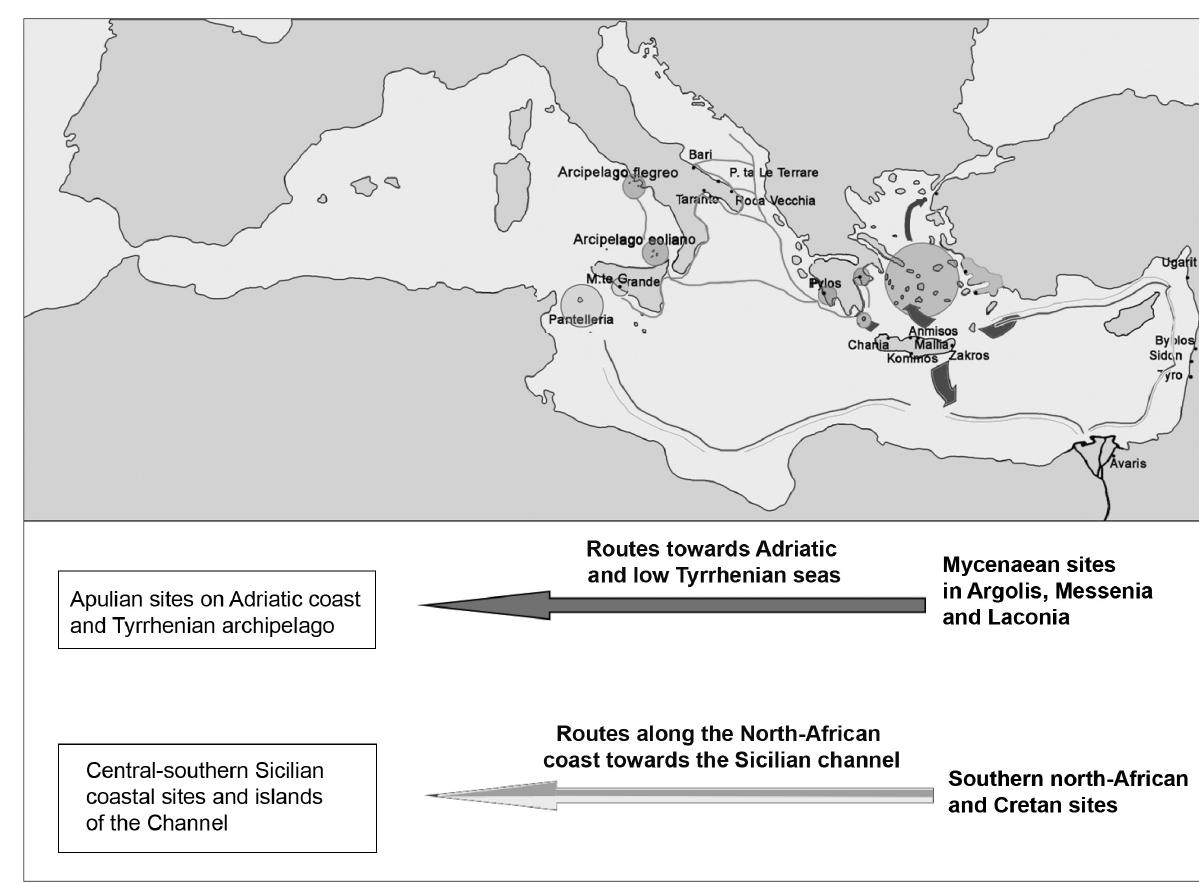
Figure 8: Outline of the main east-west maritime routes between 17 th and 15 th century BCE (after Marazzi,